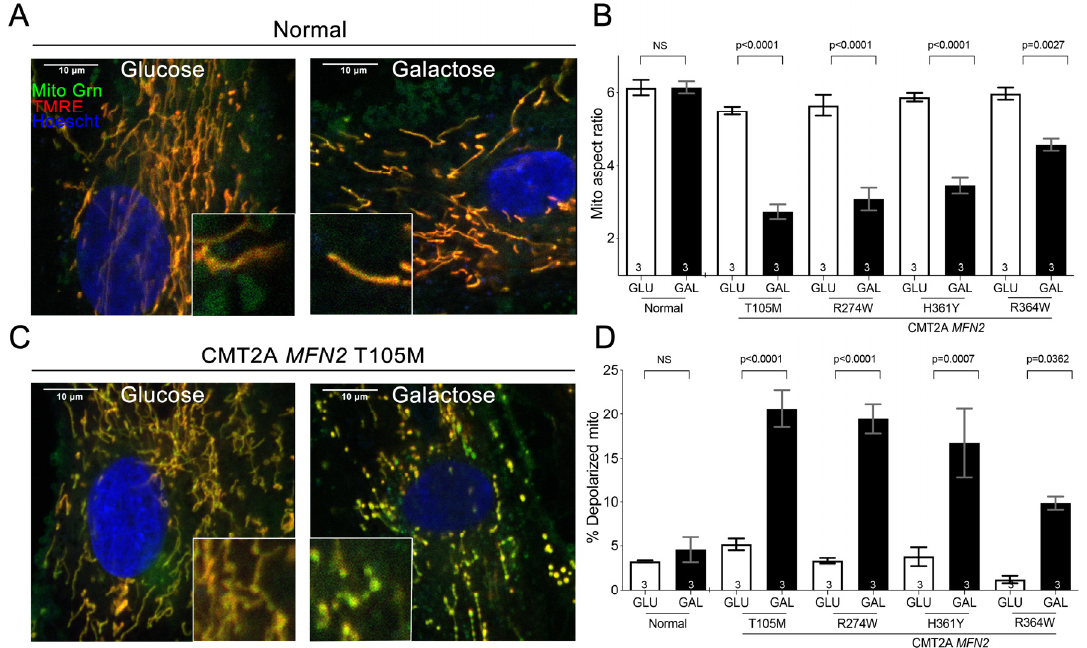
Figure 1. Redirecting fibroblast metabolism with galactose provokes mitochondrial pathology in CMT2A. ( A , C ). Representative confocal images of normal ( A ) and CMT2A ( MFN2 T105M) patient ( C ) fi- broblasts cultured in glucose or galactose; Mito Tracker Green (green), TMRE (red), Hoechst (blue). Insets show images further magnified for clarity. Healthy mitochondria are yellow/orange; de- polarized mitochondria are green. Scale bars are 10 microns. ( B , D ). Quantitative group data for normal and CMT2A patient fibroblast mitochondrial aspect ratio ( B ) and depolarization ( D ). Data are means ± SEM; statistics by two-way ANOVA, p values are at the top of the bars. NS = Nonsignificant. The number of independent experiments is shown on the bottom of each